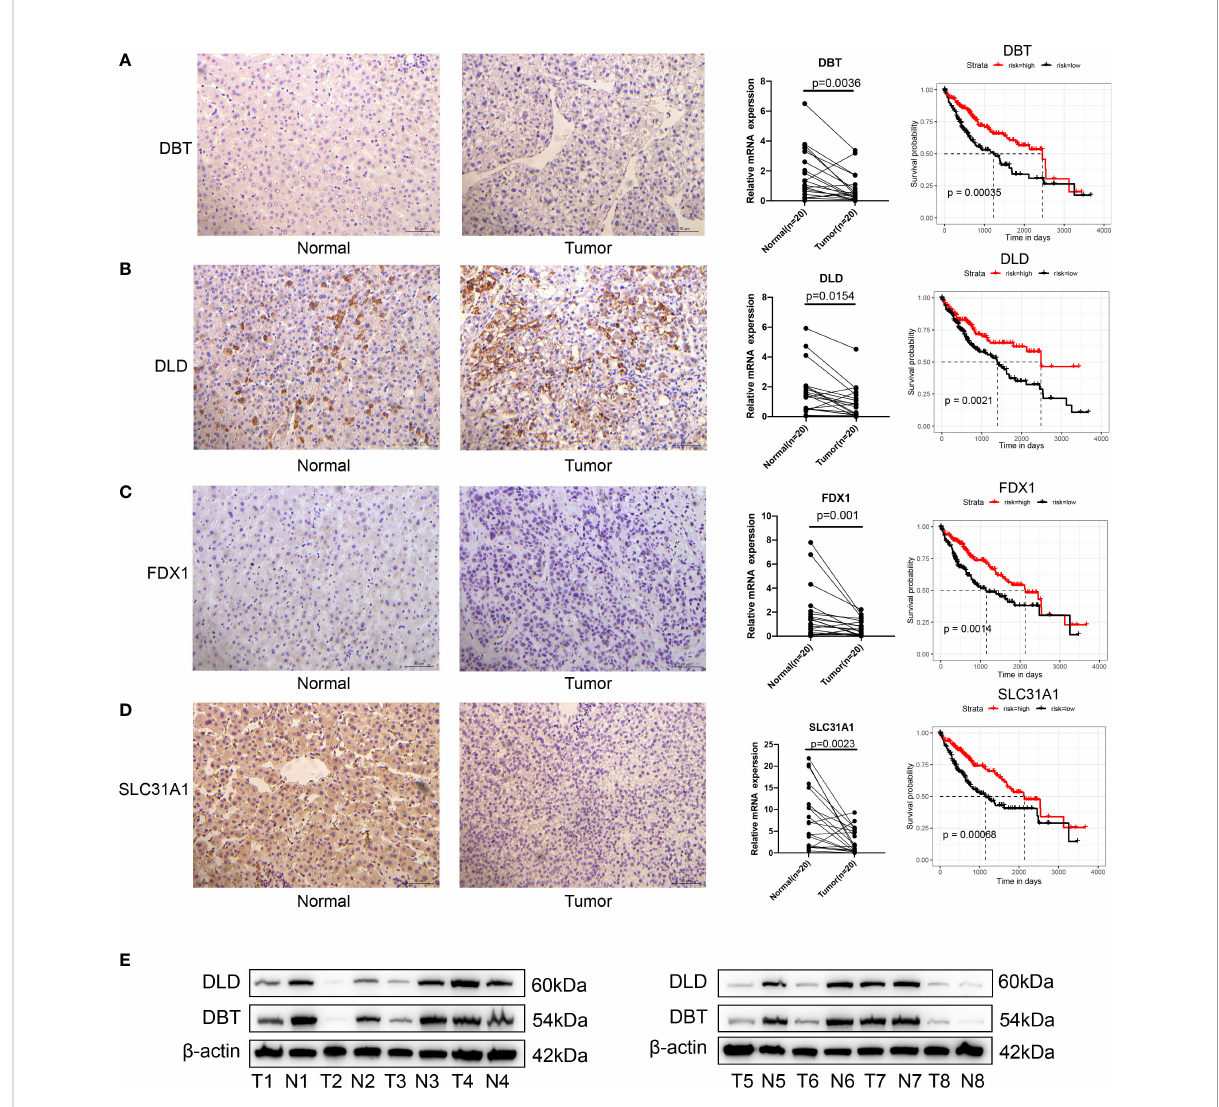
FIGURE 2 Validation of cuproptosis-related genes in HCC. (A – D) Immunohistology of DBT, DLD, FDX1 and SLC31A1 in normal and tumor tissues; qRT- PCR showed that compared with the adjacent normal tissues, FDX1, DBT, DLD and SLC31A1 were signi fi cantly expressed lower in tumor tissues; results of the KM analysis showing expressions of each cuproptosis-related gene that signi fi cantly in fl uenced the survival of TCGA. Red line represents the high-risk group and dark line the low-risk group. (E) the expression of DLD, DBT by Western blot in 8 paired tissue samples, with differences between HCC and normal